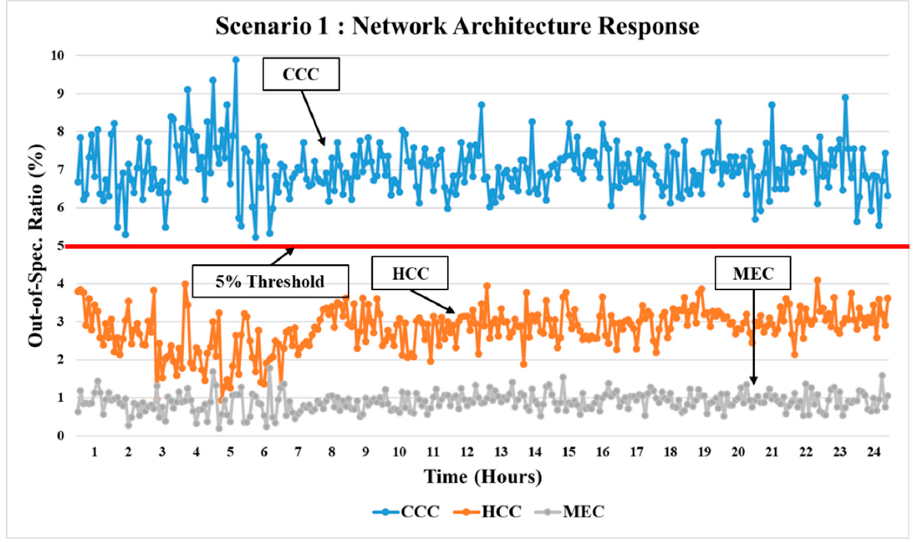
Figure 9. Individual network architecture’s response to data traffic shown in Scenario 1.